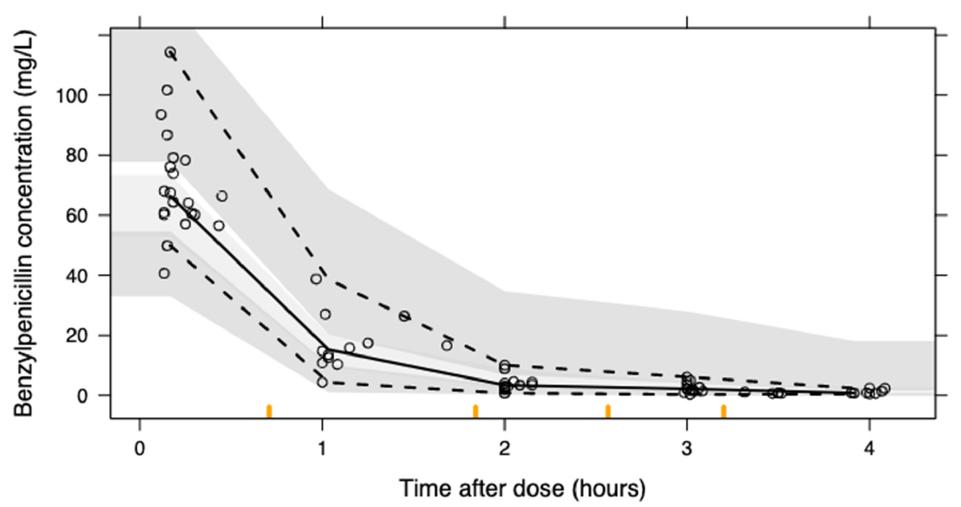
Figure 2. Goodness of fit plots for final benzylpenicillin model.